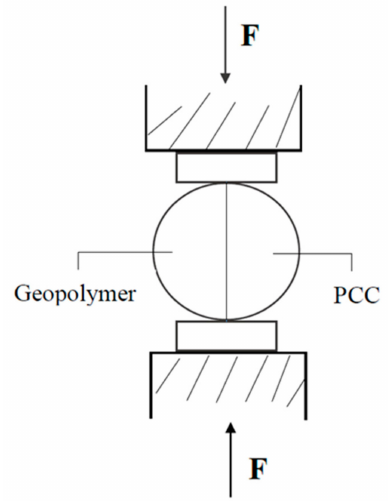
Figure 2. Split tensile test after